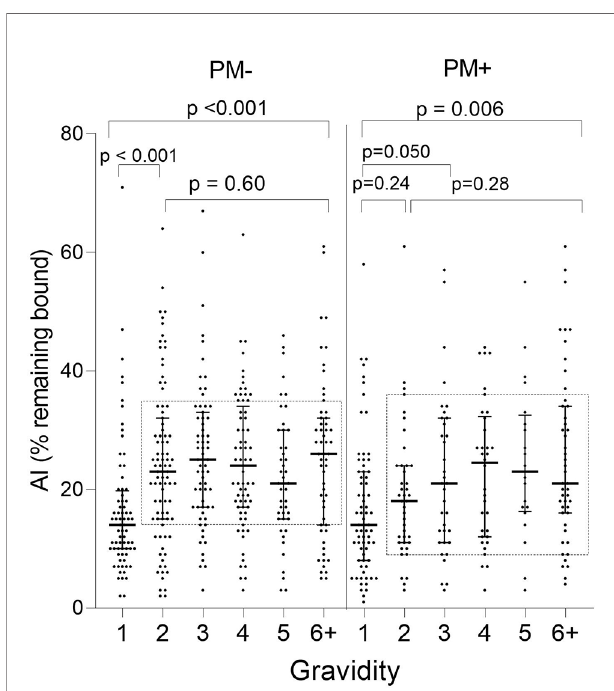
FIGURE 4 | Comparison of Ab avidity (AI) at delivery in PM − and PM+ women. A signi fi cant increase in AI occurred in PM − women between G1 and G2 women ( p < 0.001) and between G1 and G3 in PM+ women ( p = 0.05), but AI did not increase signi fi cantly thereafter (samples within rectangles for